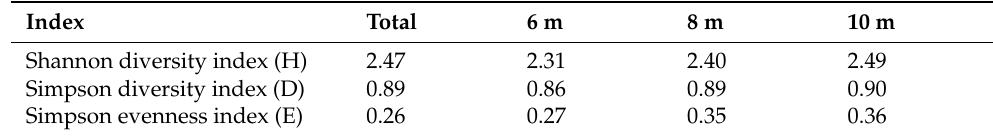
Figure 8. Number of Pinna nobilis individuals in relation to number of Anadara transversa on larval collectors in 2019 and 2020 in Javorike Cove. Note that there were no larval collectors installed at 2 and 4 m depth in 2019. Table 4. Diversity and uniformity of the fouling community on larval collectors in Javorike Cove in 2019.